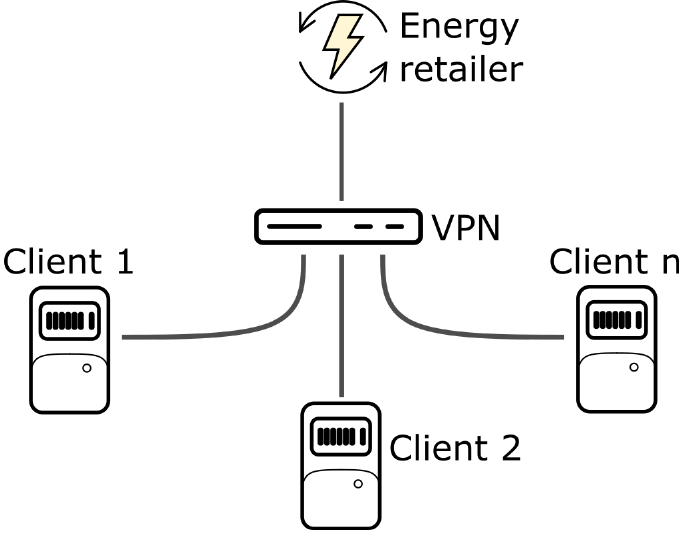
Figure 3. Proposed network